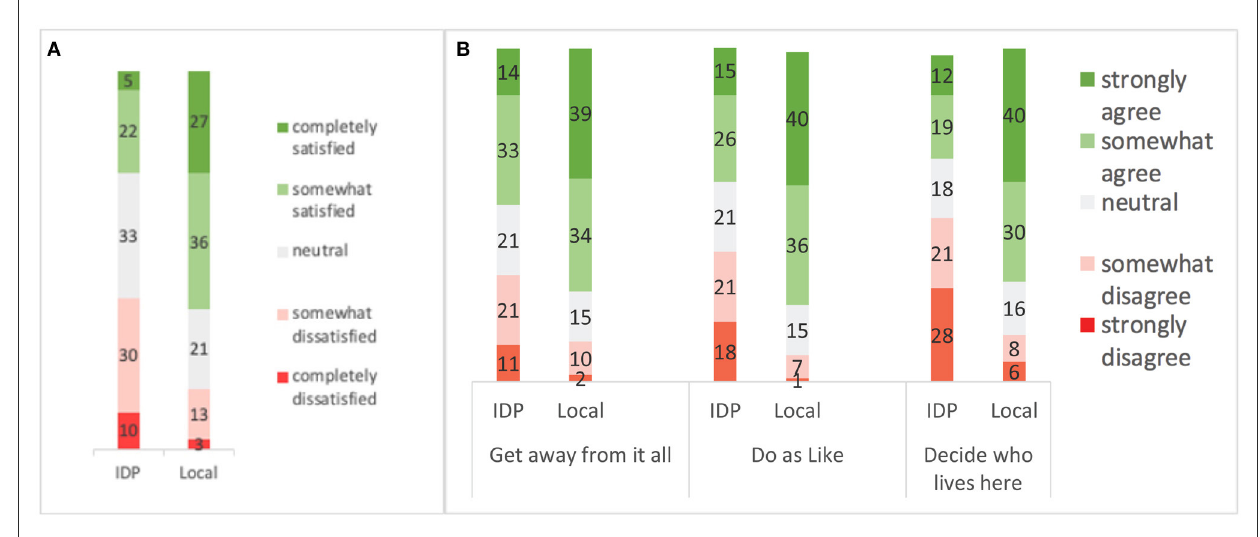
FIGURE2 (A) Satisfaction with housing conditions. (B) Sense of autonomy.